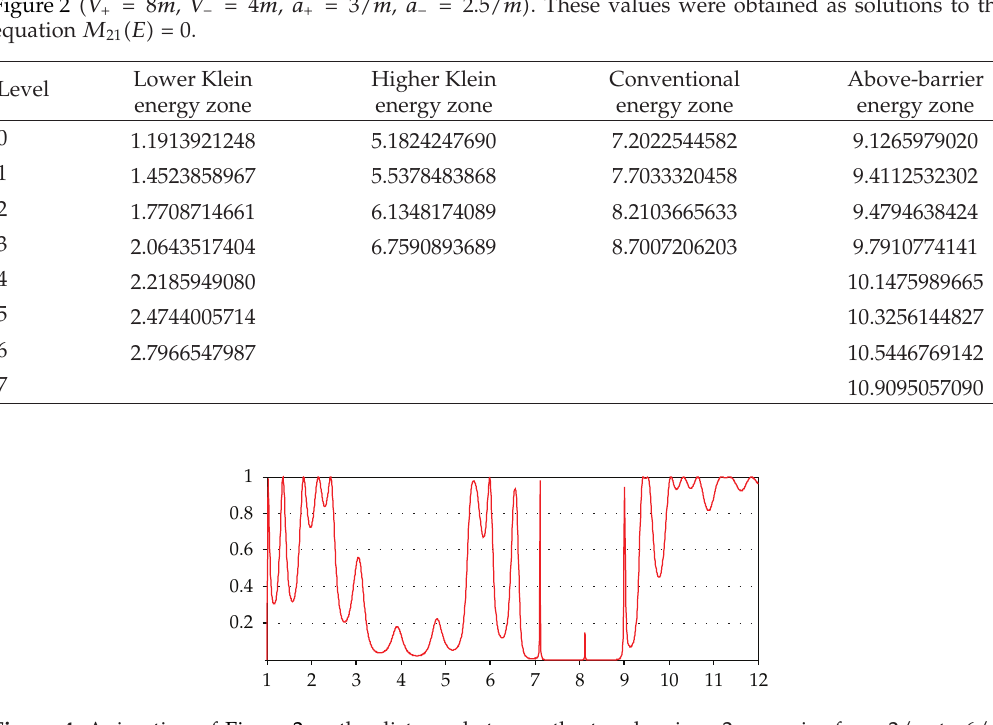
Figure 4: Animation of Figure 2 as the distance between the two barriers, 2 a − , varies from 2 /m to 6 /m (cid:3) 2.4MB MPG (cid:4)